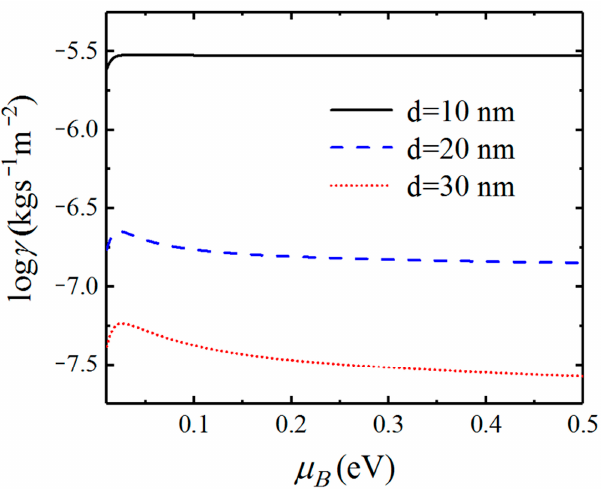
Figure 10. Dependence of the Casimir friction coefficient on chemical potential for different separation distances 𝑑 .